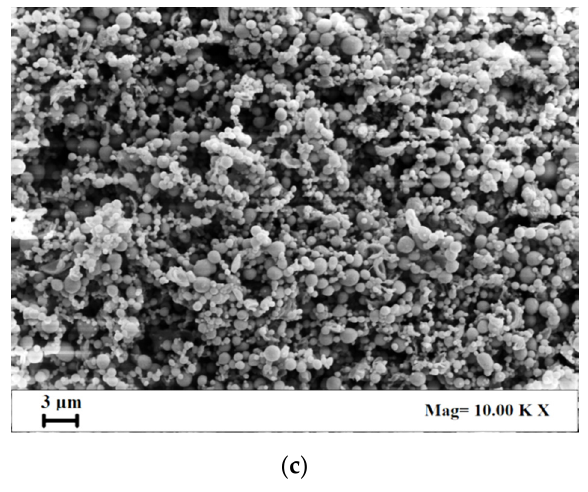
Figure 2. SEM images of 15PVDF-coHFP_10TiO 2 ( a ), 15PVDF-coHFP_20TiO 2 ( b ), and 15PVDF-coHFP_30TiO 2 ( c ).